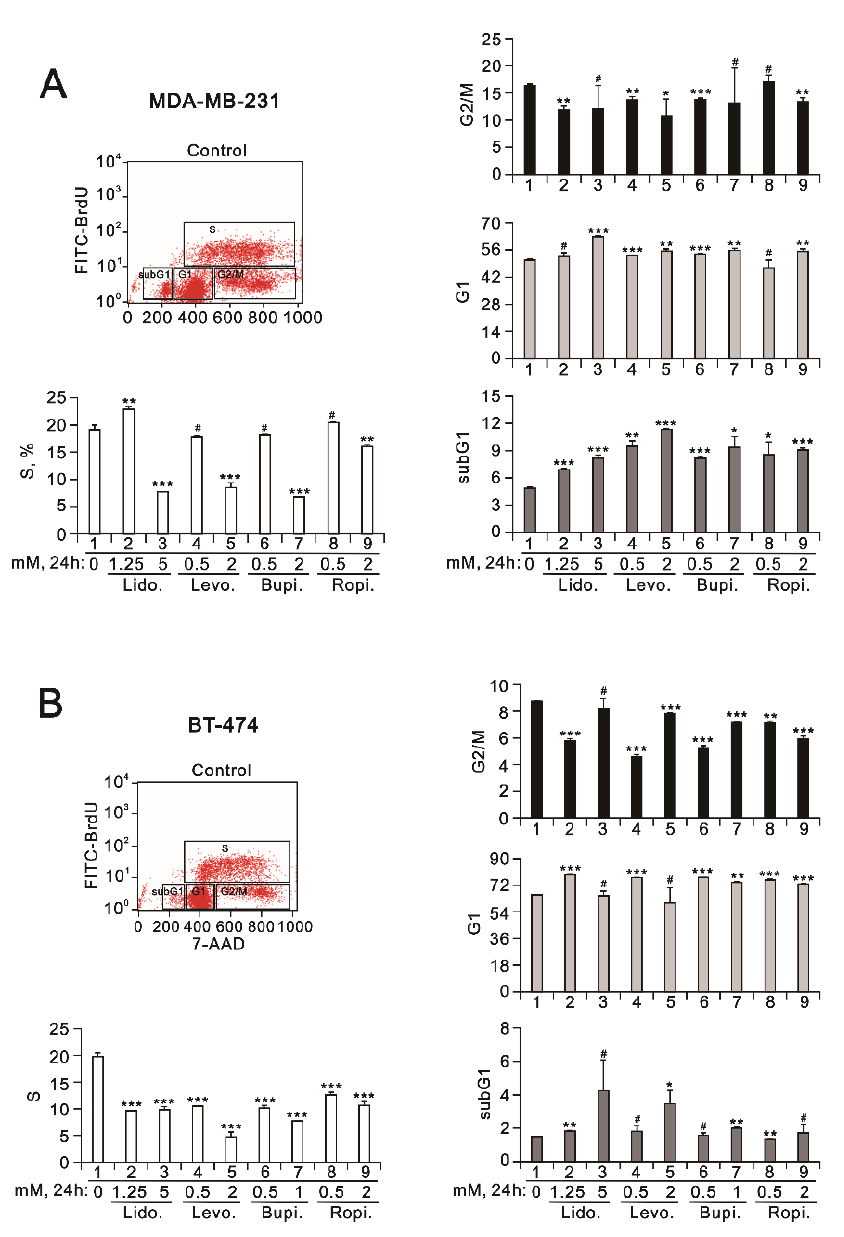
Figure 3. The effects of the local anesthetics on cell cycle profiles in MDA-MB-231 and BT-474 cells. ( A ) MDA-MB-231 and ( B ) BT-474 (3 × 10 5 ) cells were treated for 24 h with the indicated concentrations of the local anesthetics. After treatment, the cells were stained with 7-Aminoactinomycin D (7-AAD), which is a dye that can bind to total DNA, coupled with immunofluorescent BrdU staining. Four cell subpopulations (i.e., subG1, G1, S, and G2/M phases) were distinguished based on bivariate BrdU incorporation and DNA content distribution (7-AAD staining): cells in the sub-G1 phase had a lower DNA content (hypodiploid); cells in the G1 and G2/M phases were DNA diploid and tetraploid, respectively; thus, the G2/M phase fluoresced twice as brightly and there was no BrdU incorporation; cells in the S phase had the highest and relatively constant BrdU levels. The 7-AAD staining intensities defined the cell cycle position. The cell cycle profiles were measured using flow cytometry analysis. The results are representative of two independent experiments. Bars depict the mean ± SD. # p > 0.05; * p < 0.05; ** p < 0.01; *** p < 0.001.